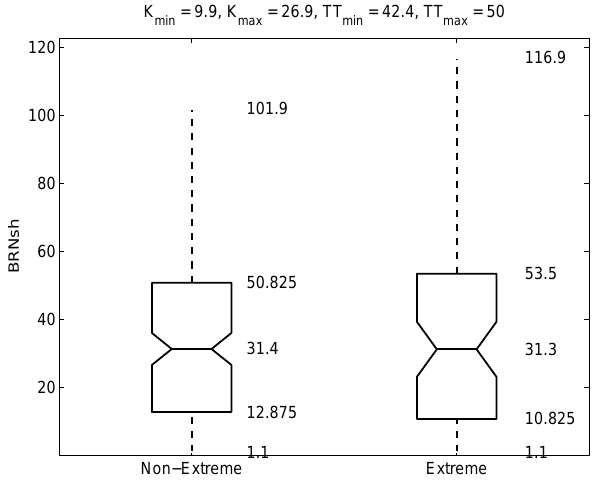
Fig. 6. The distribution of the values of the BRNsh index for the days where extreme (right) and non-extreme (left) events occurred.